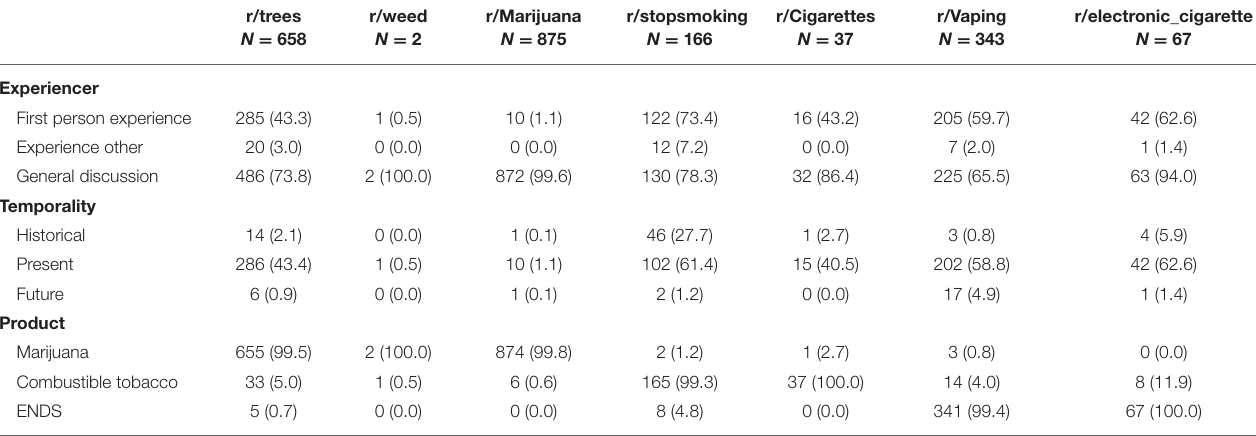
TABLE 1 | Frequencies and percentages of posts from the manual